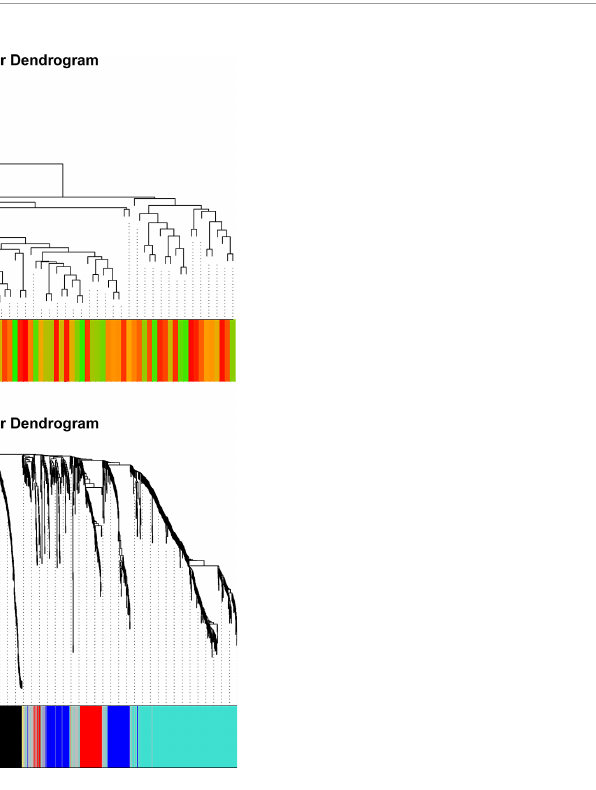
FIGURE 9 | Gene modules associated with radiomic risk scores were determined by WGCNA. (A) The association between diversi fi ed samples. (B) Cluster dendrogram and module assignment for modules from network analysis. WGCNA, weighted correlation network analysis